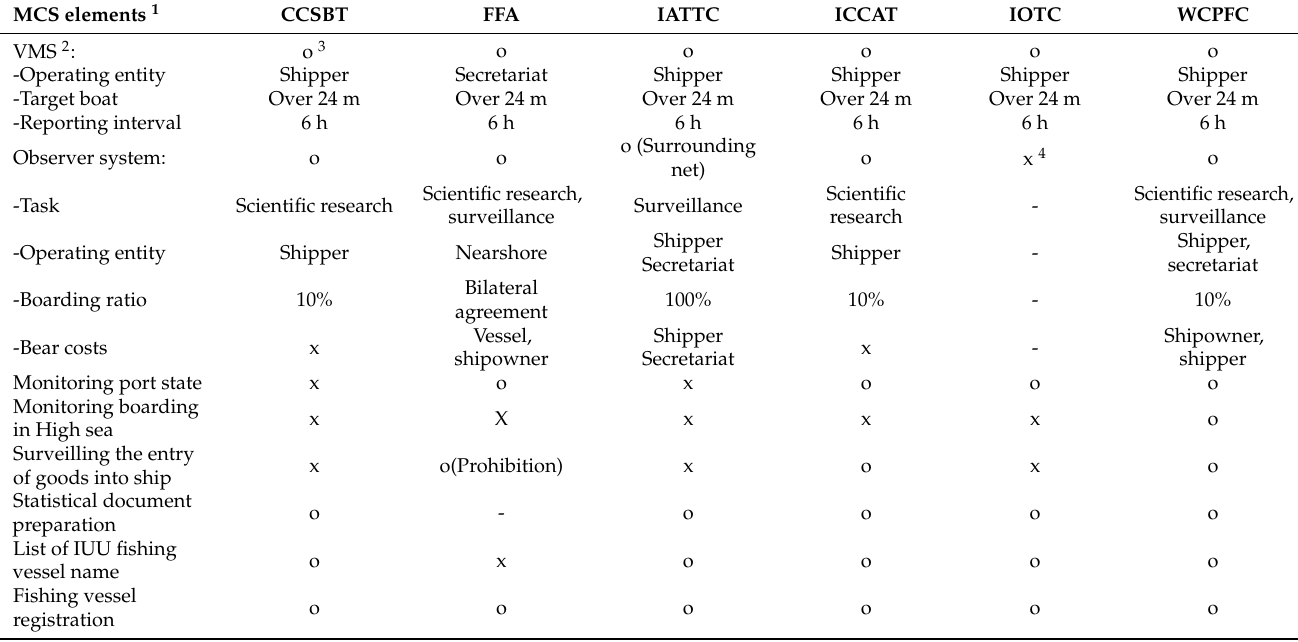
Table 1. The current status of MCS operation system of local fisheries organizations related to highly migratory fish resources